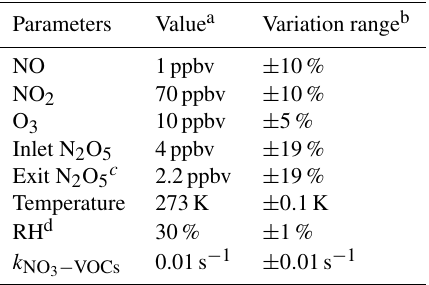
Table 3. Parameters involved in the Monte Carlo